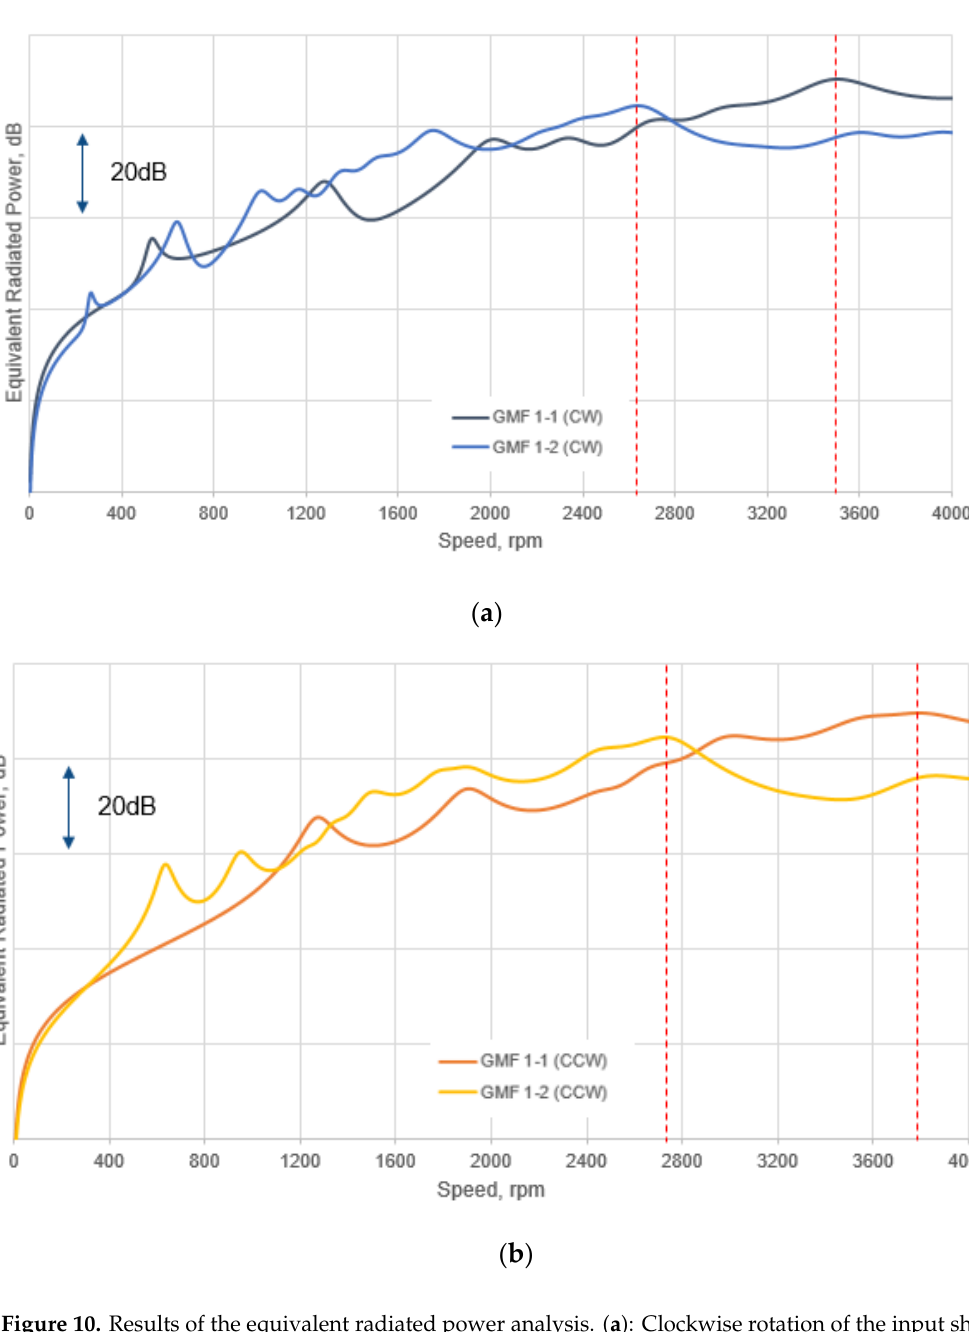
Figure 10. Results of the equivalent radiated power analysis. ( a ): Clockwise rotation of the input shaft; ( b ): Counterclockwise rotation of the input shaft.